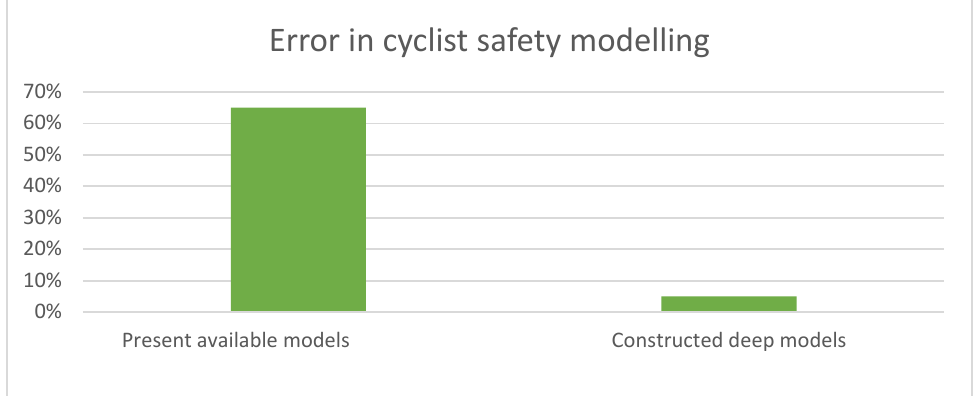
Figure 3. Comparison of the created model to currently accessible models in the literature.